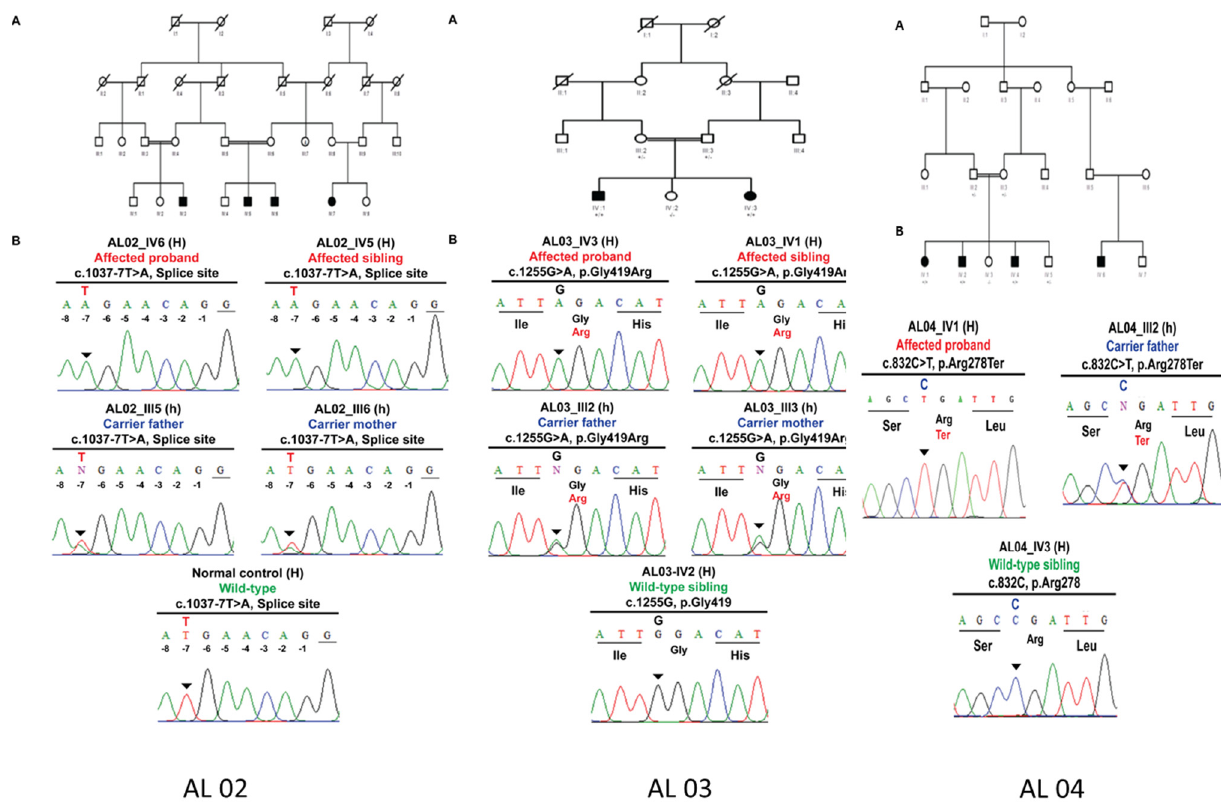
( A ) Pedigree structure of AL02 family. ( B ) Sanger sequencing electropherograms reflecting familial segregation of TYR c.1037-7T>A pathogenic variant in AL02 family. Homozygous missense p.Gly419Arg variant in AL03 family manifesting albinism. ( A ) Pedigree structure of AL03 family. ( B ) Sanger sequencing electropherograms reflecting familial segregation of TYR p.Gly419Arg pathogenic variant in AL03 family. Homozygous nonsense TYR p.Arg278Ter variant in AL04 family manifesting albinism. ( A ) Pedigree structure of AL04 family. ( B ) Sanger sequencing electrophero- grams reflecting familial segregation of TYR p.Arg278Ter pathogenic variants in AL04 family. Table 2. Novel and reported TYR , OCA2 and HPS-1 variants identified in albinism families in this study.